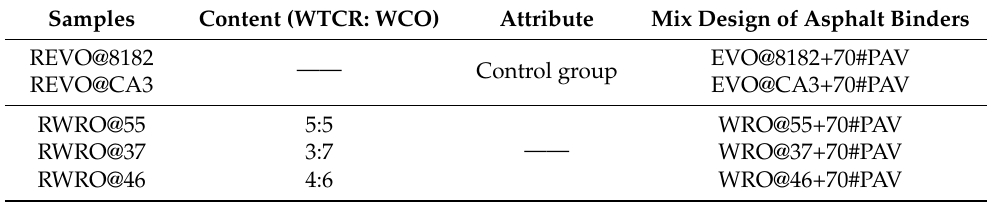
Table 4. The asphalt samples utilized in this research.